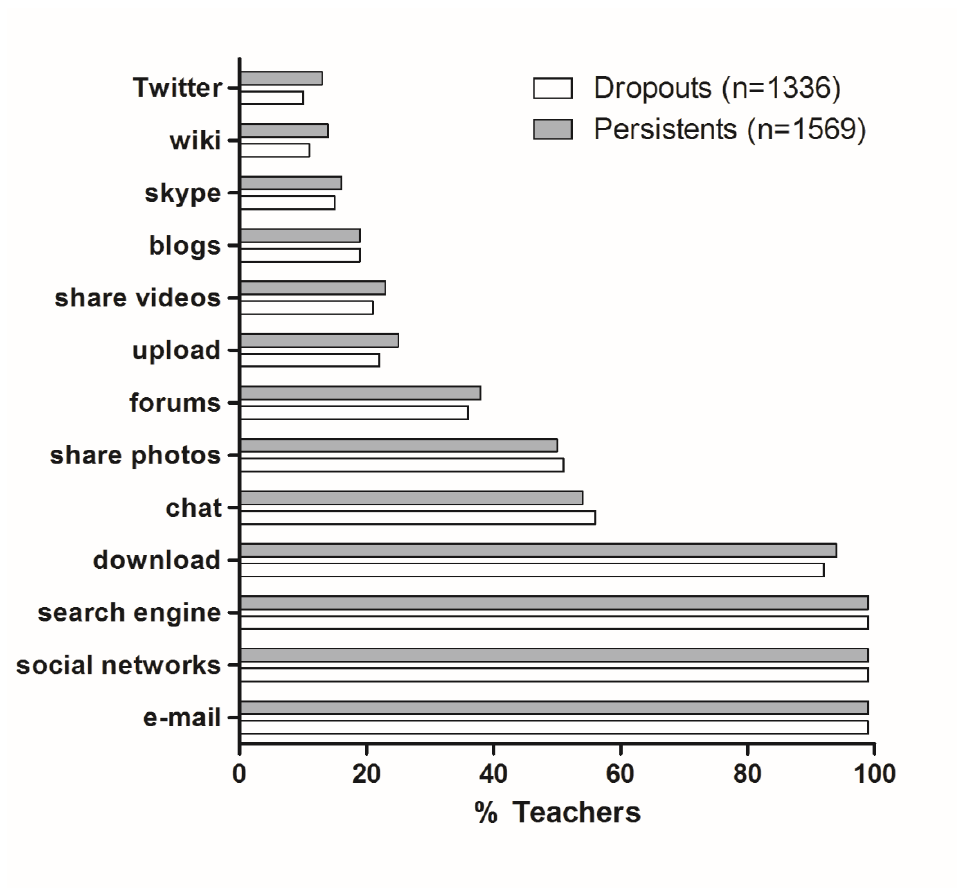
Figure 2. Use of 13 Internet tools by